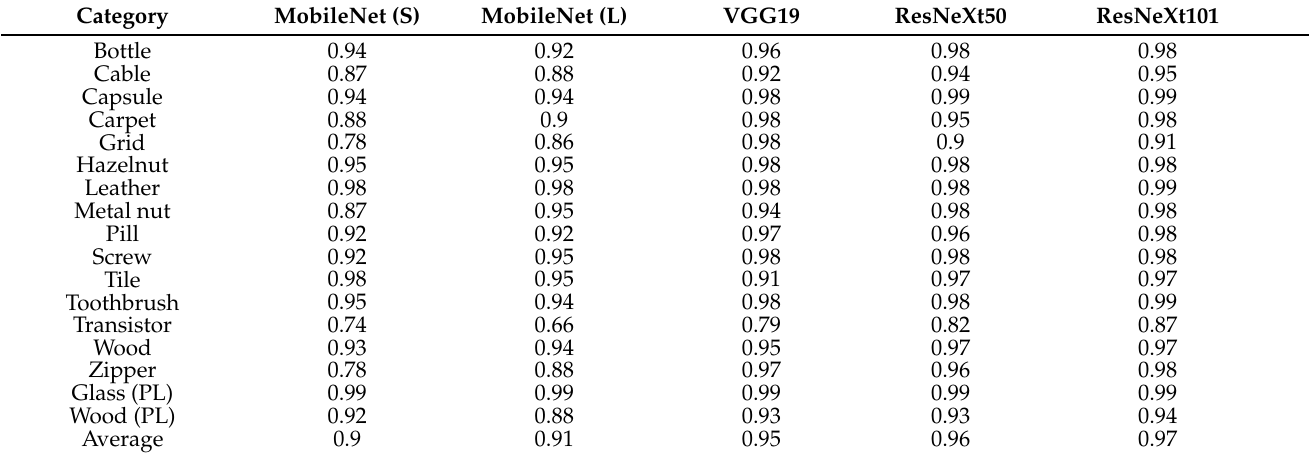
Table 5. AUCs of proposed method with different pre-trained CNN feature